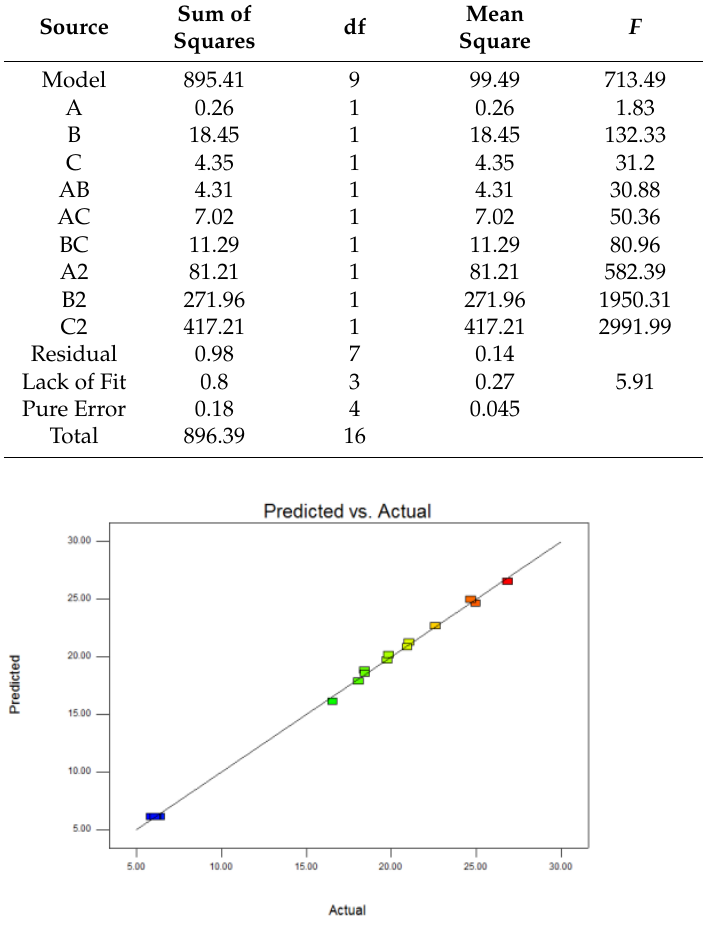
Figure 3. Experimental response values versus predicted response value of Fe 3+ content.